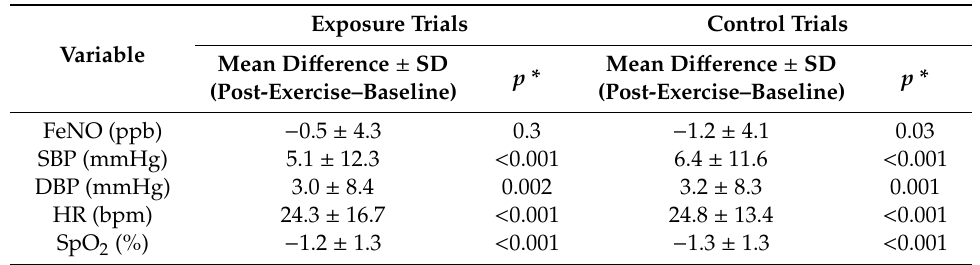
Table 3. Mean di ff erences between post-exercise measurements obtained in 76 participants during exposure and control trials.